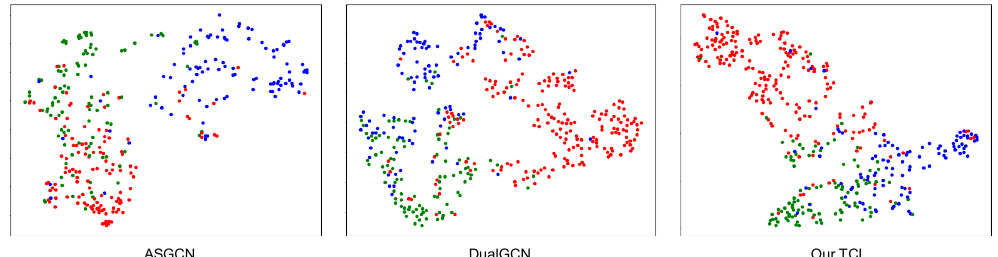
Figure 7. Visualization of sentiment classification results. The dots in green, red and blue respectively represent the positive, neural and negative